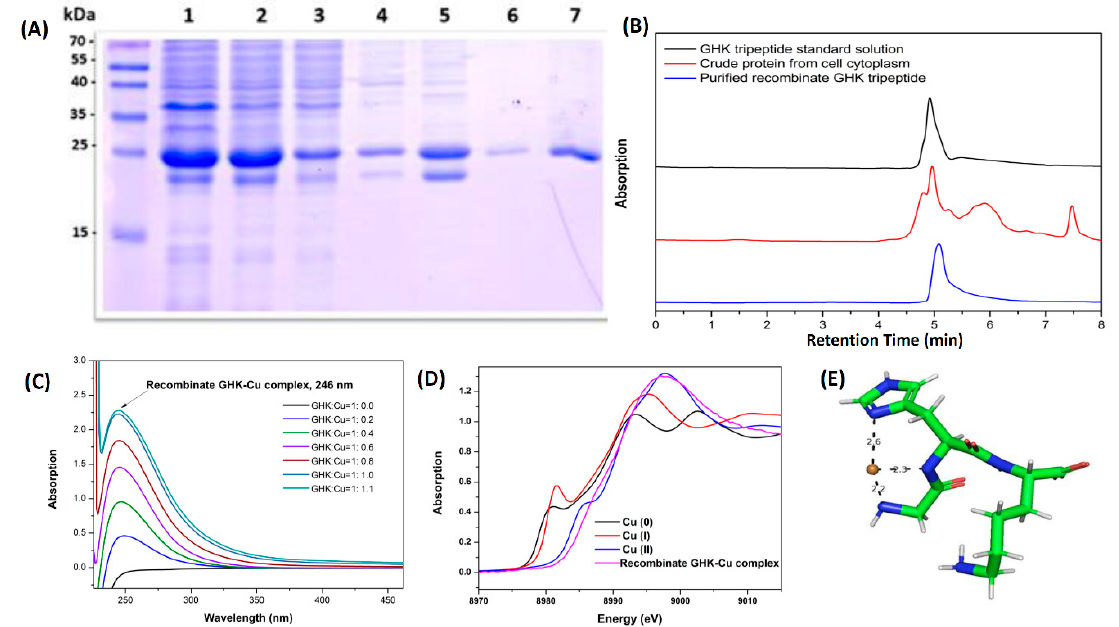
Figure 2. Expression, purification, and characterization of the recombinant GHK tripeptide. ( A ) Expression of a recombinant protein containing a GHK tripeptide. Lane 1: cell total lysate; Lane 2: crude protein in the supernatant part; Lane 3: flowthrough by a Ni-NTA (nitrilotriacetic acid) agarose base his-taq a ffi nity column; Lane 4: elute with 0 mM of imidazole in a Ni-NTA agarose base his-taq a ffi nity column; Lane 5: elute with 40 mM of imidazole in a Ni-NTA agarose base his-taq a ffi nity column; Lane 6: elute with 80 mM of imidazole in a Ni-NTA agarose base his-taq a ffi nity column, Lane 7: Ni-NTA agarose bead content with a recombinant 6XHis-GST-GHK peptide. ( B ) The recombinant GHK peptide fractions were purified with a C18 reverse-phase column by HPLC. Both of the retention times of recombinant GHK peptide (red color) and GHK standard (black color) were 5 min. ( C ) Spectrophotometry analysis of copper and recombinant GHK peptide interaction at di ff erent molar ratio combinations. The specific absorption peak of the recombinant GHK-Cu complex was 246 nm. The concentration of the recombinant GHK peptide was 1 mg / mL. ( D ) X-ray near-edge spectrophotometry analysis of copper foil (Cu(0)), Cu 2 O (Cu(I)), CuO (Cu(II)), and the recombinant GHK-Cu peptide. ( E ) X-ray crystal structure of the GHK peptide when associated with the copper ion.